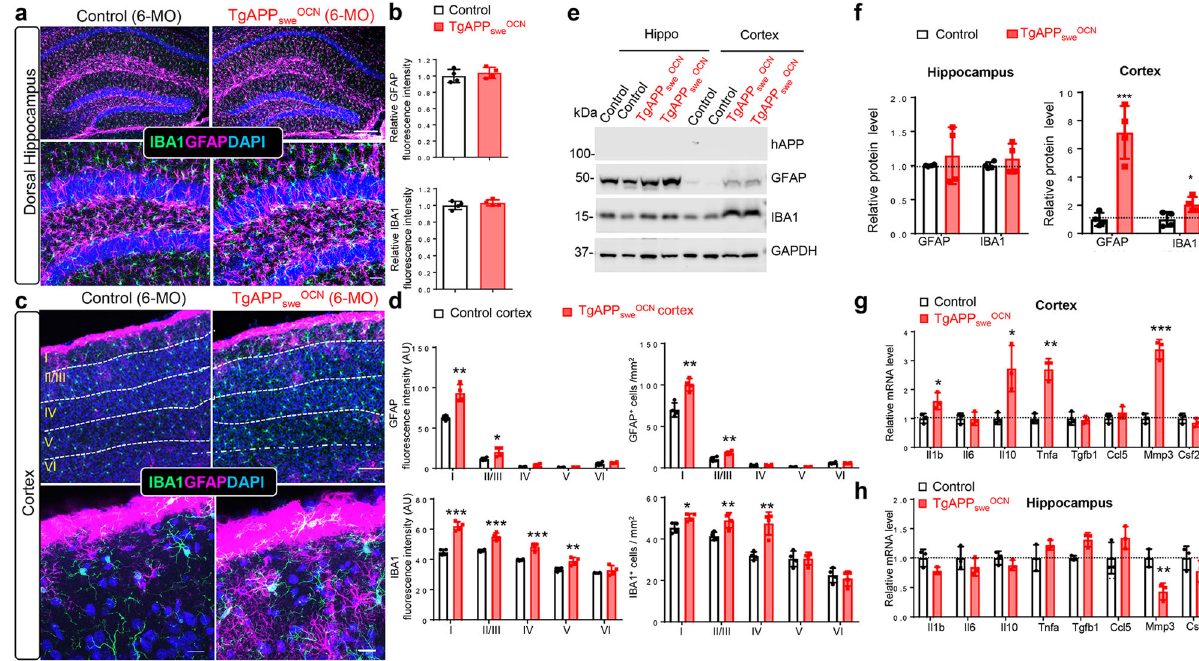
Fig. 2 Elevated reactive astrocytes, microglial cells, and in fl ammatory cytokines in 6-MO TgAPP swe OCN cortex, but not hippocampus. a Representative images of co-immunostaining with IBA1 (green), GFAP (magenta), and DAPI (blue) of hippocampal sections from 6-MO control (LSL-APP swe ) and TgAPP swe OCN mice. Scale bars: 200 µ m (upper) and 20 µ m (lower). b Quanti fi cation of data in a . c Representative images of co-immunostaining with IBA1 (green), GFAP (magenta), and DAPI (blue) of cortex sections from 6-MO control ( LSL-APP swe ) and TgAPP swe OCN mice. Scale bars: 100 µ m (upper) and 20 µ m (lower). d Quanti fi cation of data in c . e Representative Western blots using antibodies against hAPP, GFAP, and IBA1 in homogenates of cortex and hippocampus of control and TgAPP swe OCN mice. GAPDH was used as a loading control. f Quanti fi cation of the data in e . g – h Real-time PCR (RT-PCR) analysis of indicated gene expressions in 6-MO control ( LSL-APP swe ) and TgAPP swe OCN cortex ( g ) and hippocampus ( h ). All quanti fi cation data were presented as mean ± SD ( n = 3 – 4). * p < 0.05, ** p < 0.01, *** p < 0.001. Student ’ s t test was used in b , d , and f – h